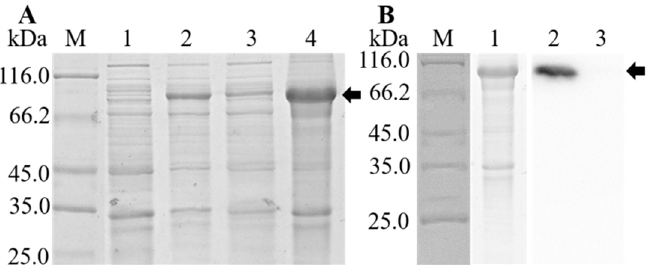
Figure 5. ( A ) Identification of prokaryotic protein expression of rOn-TF by SDS-PAGE. rOn-TF is shown with a black arrow. Line M: protein molecular marker; line 1, 2, 3, and 4: bacteria with Pcold-zz-On-TF without IPTG induction, bacteria with IPTG induction, bacteria soluble pro- tein with IPTG induction, and bacteria inclusion body protein with IPTG induction, respectively. ( B ) Identification of purified rOn-TF by SDS-PAGE (line 1) and western blot (line 2 and 3). rOn-TF is shown with a black arrow; M: protein molecular marker; line 1: purified rOn-TF; line 2: experiment group (use mouse anti-his IgG); line 3: control group (use mouse